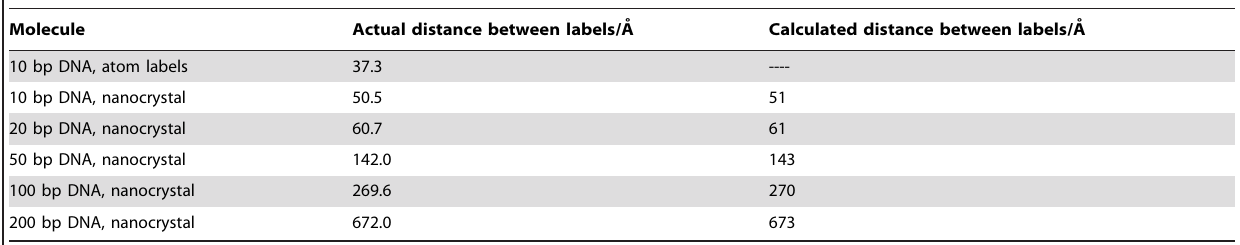
Table 2. Distances between label atoms or nanocrystals.